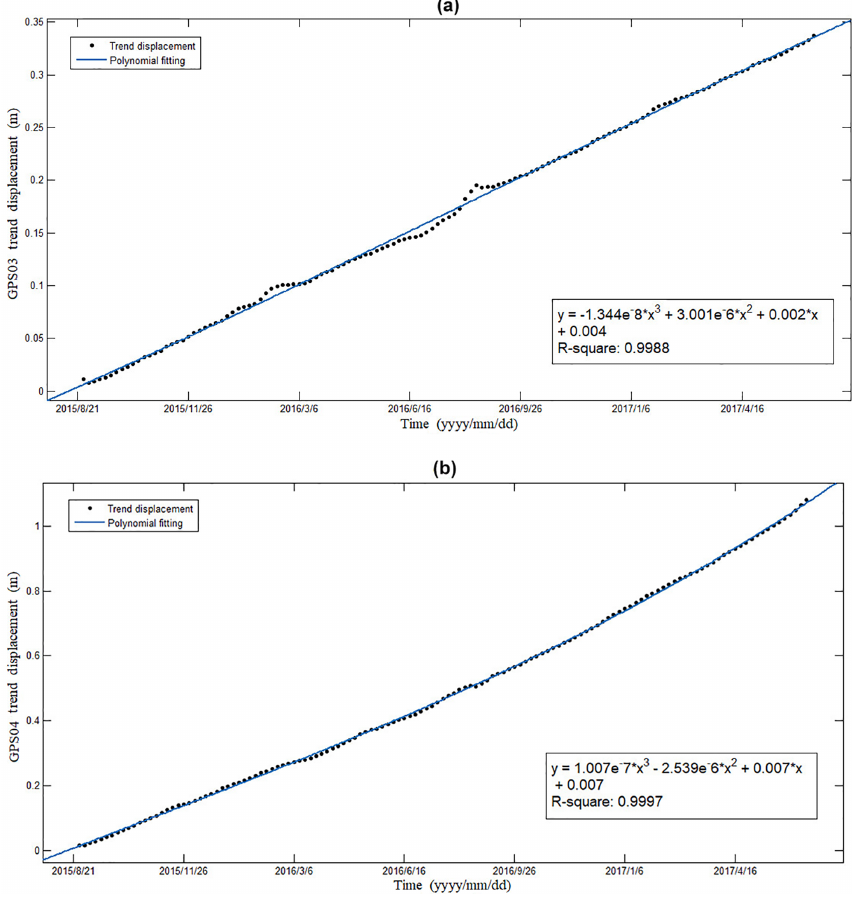
Figure 5. The trend-term displacement prediction of (a) station GPS03 and (b) station GPS04.